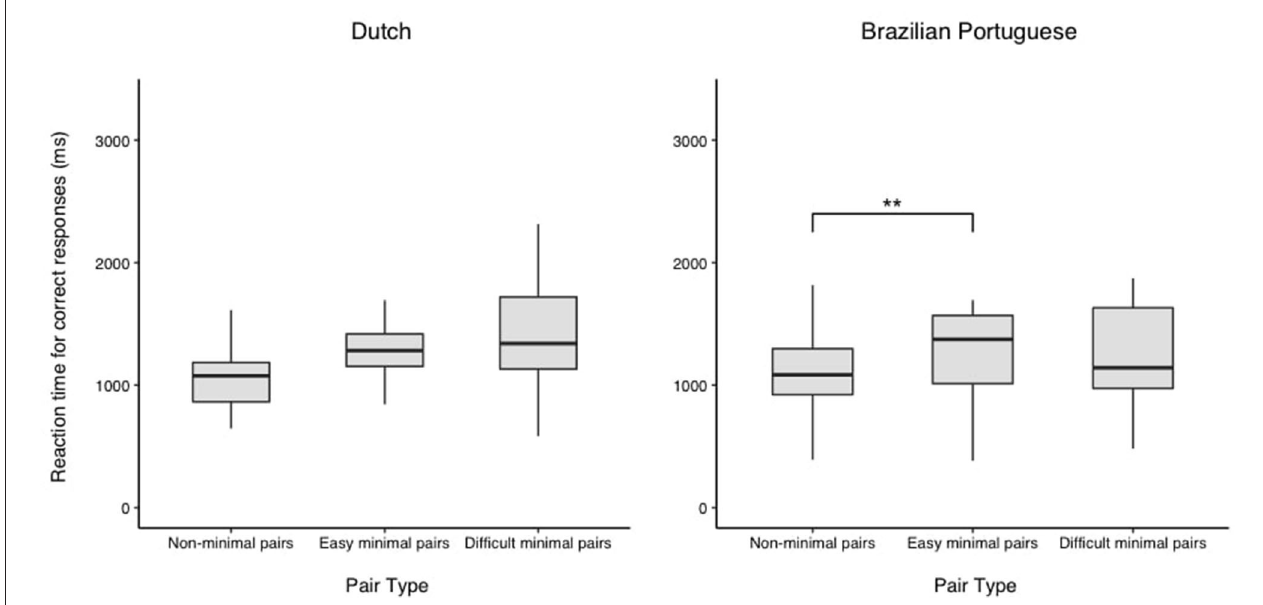
FIGURE 4 | Participants’ reaction times for correct responses across pair types for Dutch and Brazilian Portuguese. ** p < 0.01.